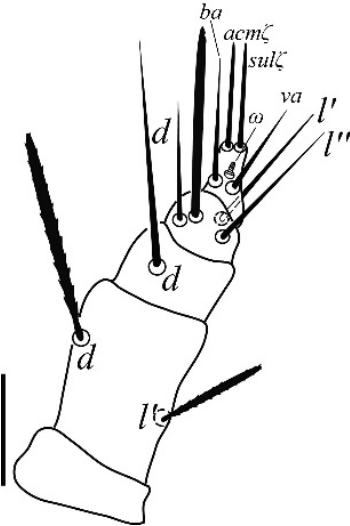
Figure 1. Neophyllobius combreticola . Female. Gnathosoma. Scale bar: 20 μ m.